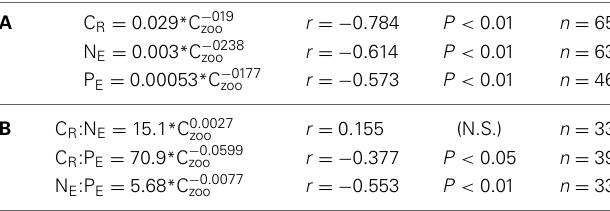
FIGURE 2 | Relationships between individual biomass of experimental zooplankton ( µ mol C ind − 1 ) and C-specific metabolic rates. Black dots: Respiration (d − 1 ); open squares: µ mol NH 4 -N µ mol C − 1 zoo day − 1 ; Black triangles: µ mol PO 4 -P µ mol C − 1 zoo day − 1 . The values for salps are indicated by larger symbols and enclosed in a shaded circle. The corresponding equations are indicated in Table 3A . Table 3 | Equations relating individual zooplankton biomass (C zoo ) with (A): C-specific metabolic respiration (C R) , and ammonia and phosphate excretion rates, N E and P E respectively, and (B): with C R :N E , C R :P E and N E :P E metabolic quotients (atoms) corresponding to Figures 2, 3.